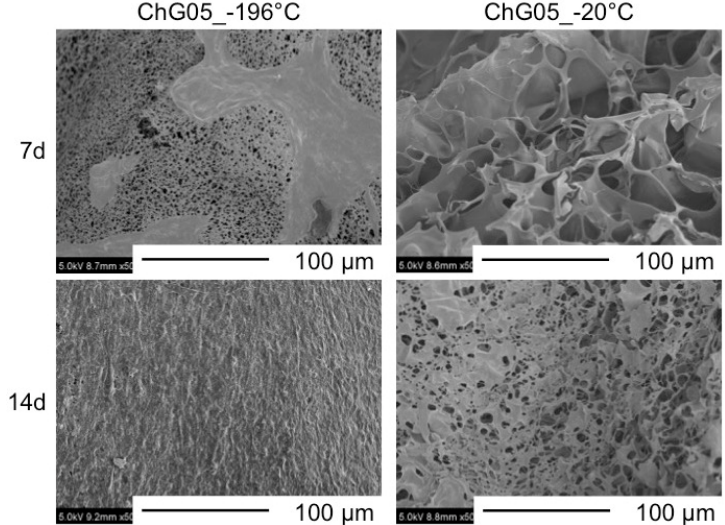
Figure 5. SEM images of MG63 cells cultured on surfaces of ChG05 chitosan − siloxane hybrid spheres